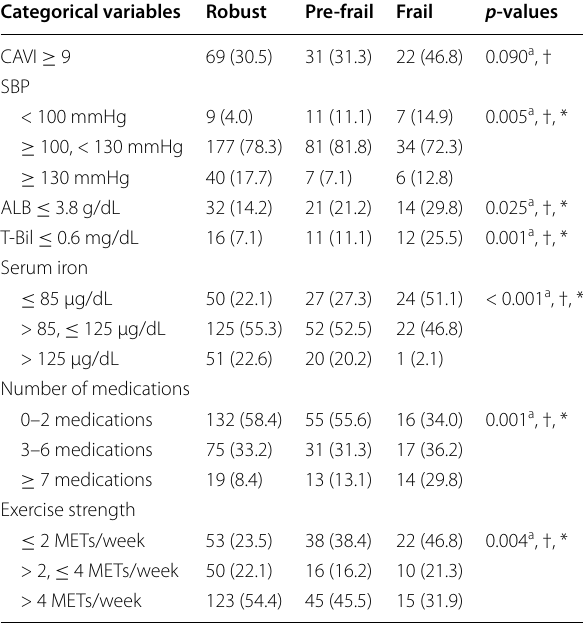
Table 2 Chi-square test for categorical variables created from continuous variables stratified by frailty status